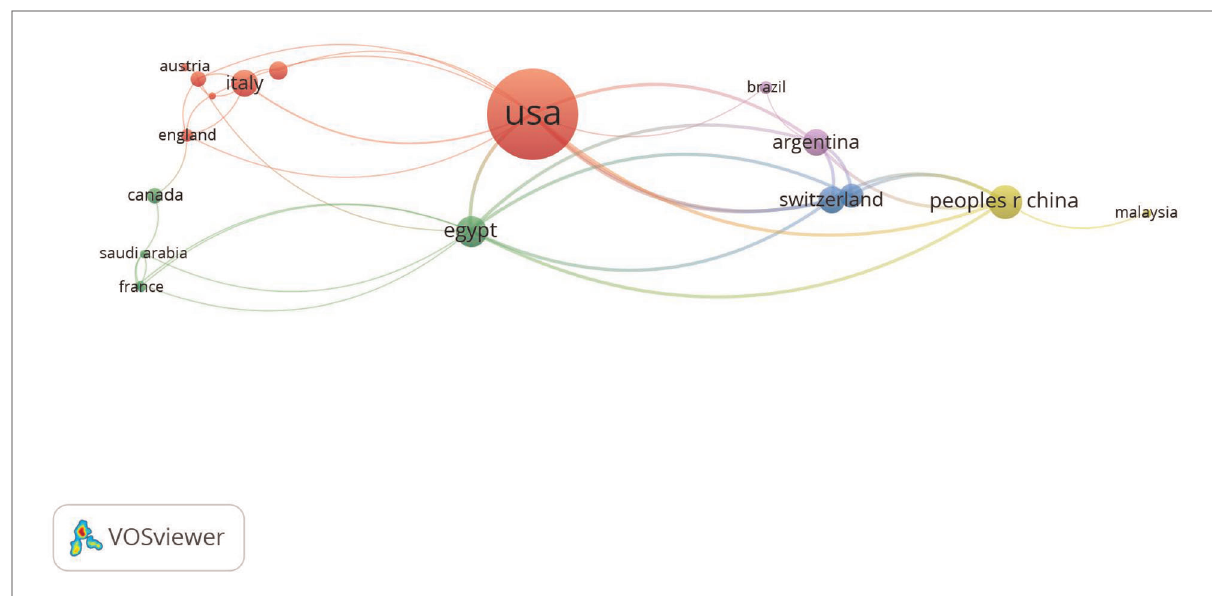
FIGURE 1 International collaboration analysis among different countries/regions.